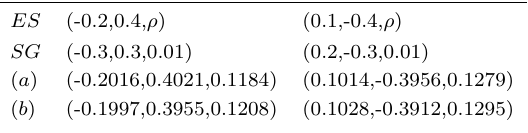
Table 3. The approximate location and the size of sub-domains with the constant using LMA and TRA with exact solution ( ES ) and the starting guess ( SG ) along with 1% noise data for Example